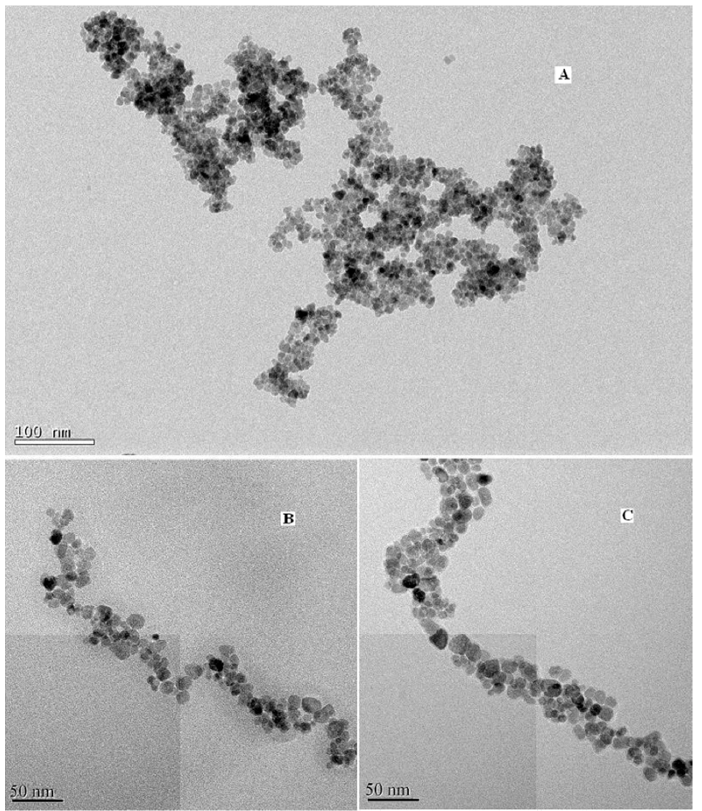
Figure 3. Transmission electron microscopy (TEM) images of ( A ) Fe 3 O 4 nanoparticles; ( B ) SMN and ( C ) DAPD-SMN.